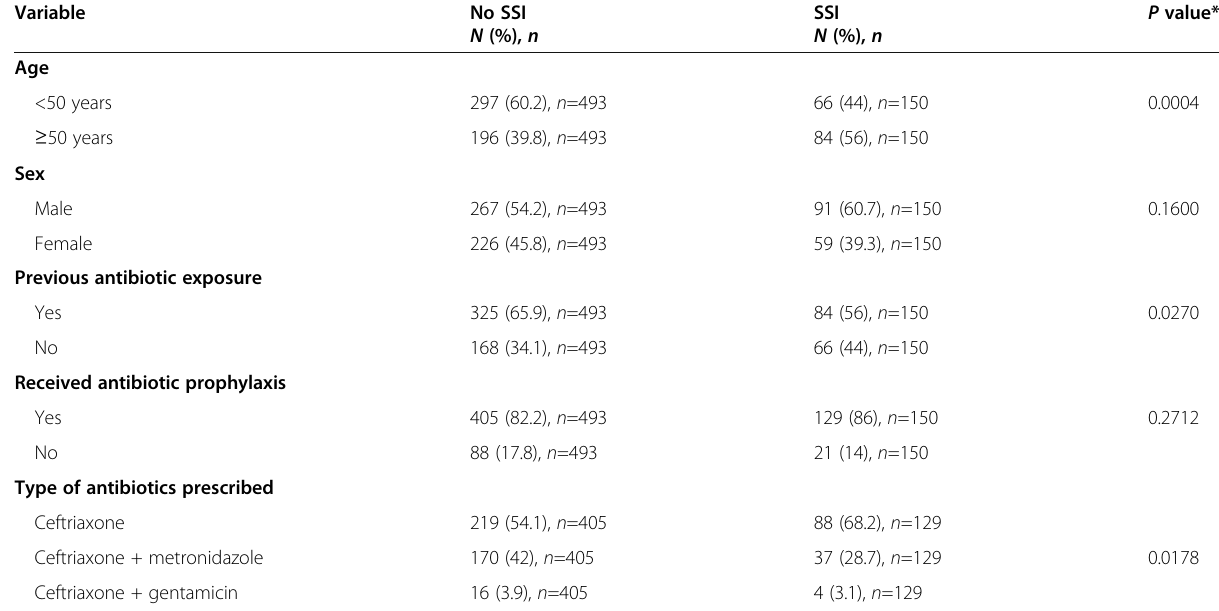
Table 2 Various factors selected for the study of SSI Variable